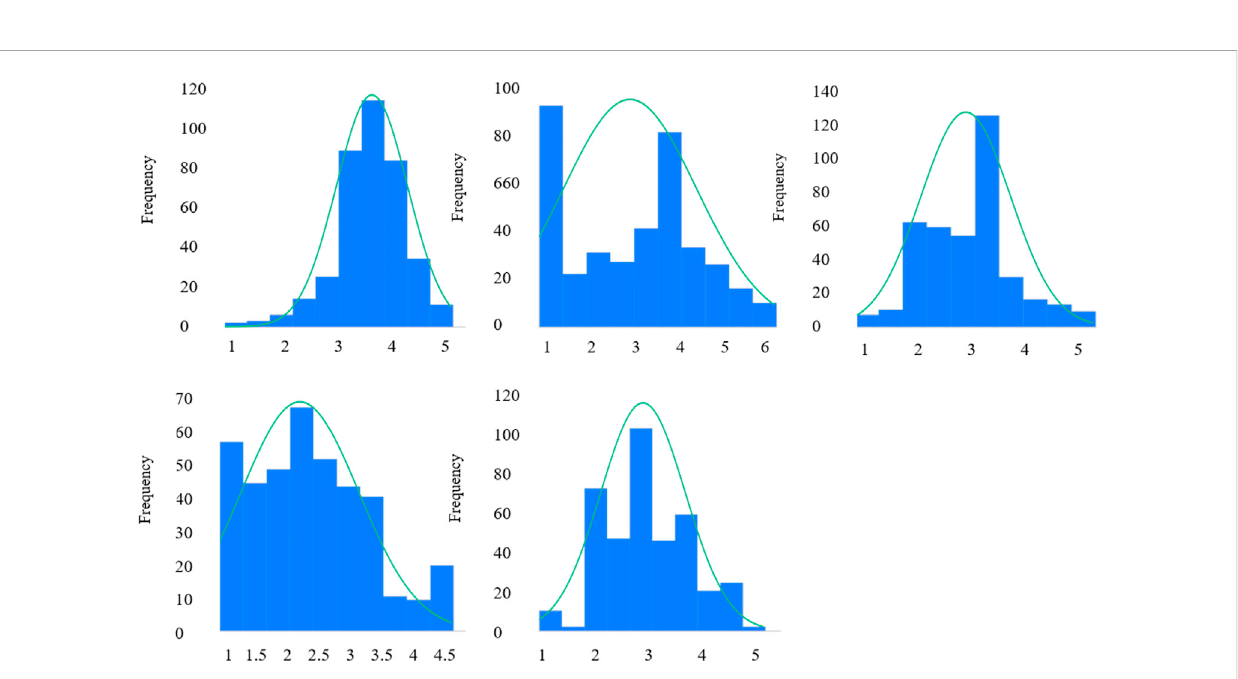
FIGURE 3 Normality test histograms for different educational